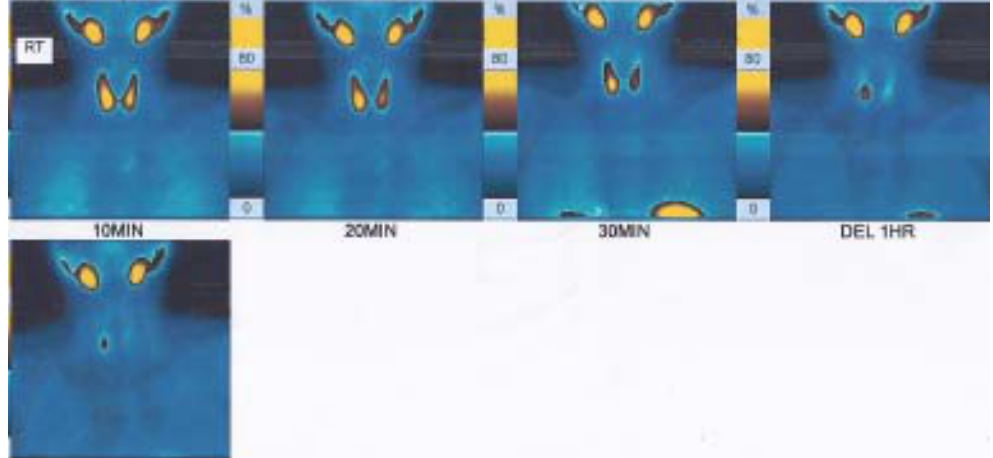
Figure 2. Sestamibi scan showing right parathyroid